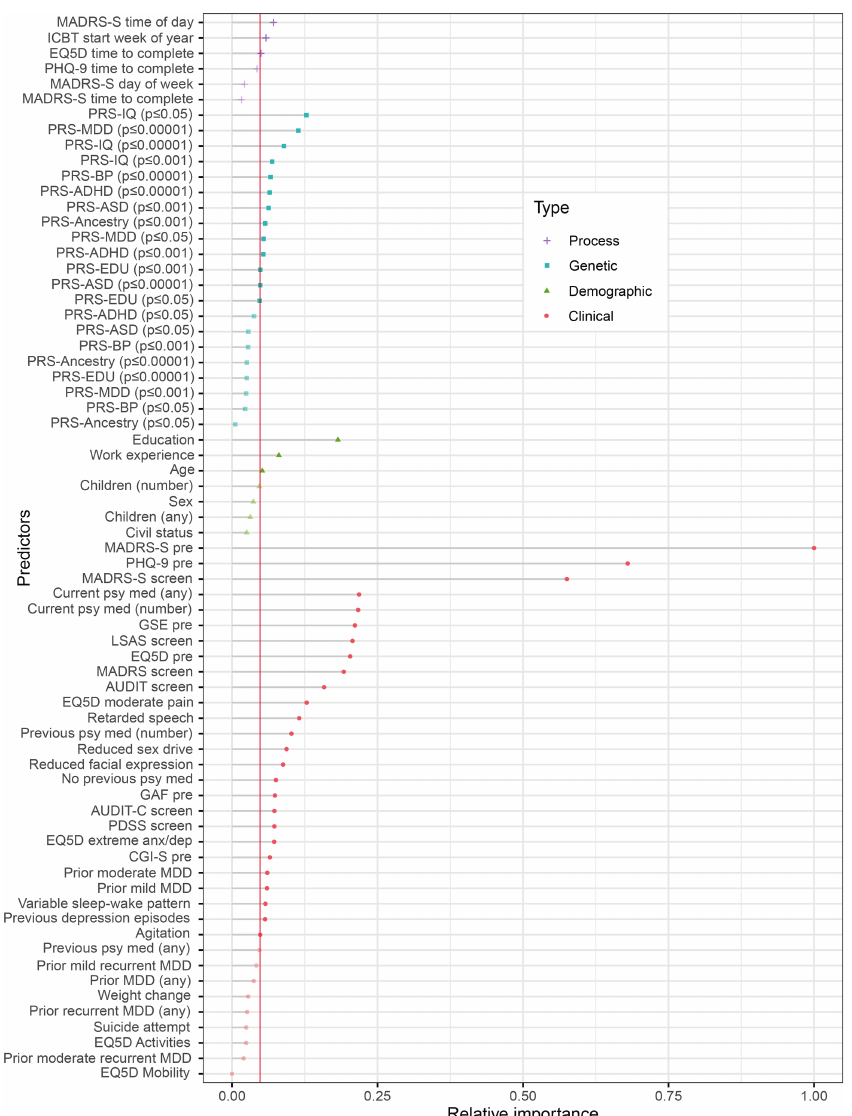
Fig. 2 Individual predictors sorted by predictor type and relative Gini importance for predicting remission post ICBT in adults with MDD. Needle length on the x-axis represents relative importance with the strongest predictor scaled to 1 and others as proportional fractions of 1. Colour groups predictors into one of four categories (Process, Genetic, Demographic, and Clinical). The vertical line de fi nes the RFE cut-off for fi nal model inclusion which 45 retained variables (solid dot) and discarded 24 predictors (transparent dot). Total sample n = 894. ICBT Internet- based Cognitive Behaviour Therapy, MDD Major Depressive Disorder, RFE Recursive Feature